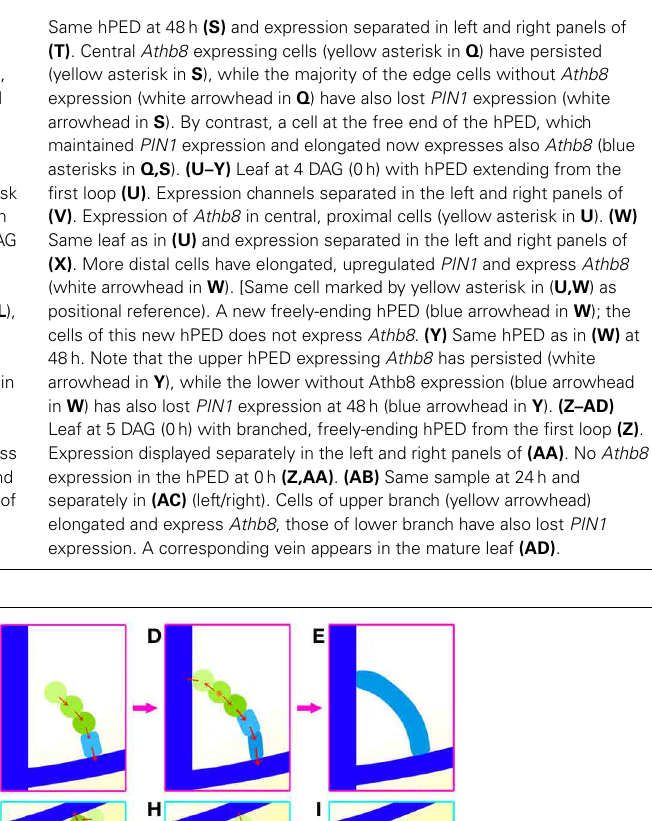
commitment, indicated by Athb8 expression (light blue). (F–I) hPED formation from domain > 2-cells wide and hPED competition. Cells at edges display inward PIN1 polarity followed by loss of PIN1 expression, thereby narrowing the hPED (F,G) . Concomitantly, central cells upregulate PIN1 , elongate and express Athb8 (light blue), indicating their vascular selection. Local competition between hPED for auxin may contribute to observed dynamic instability (G–I) . A faint hPED is more likely to disappear when emerging near an advanced wide hPED with committed vascular cells in the